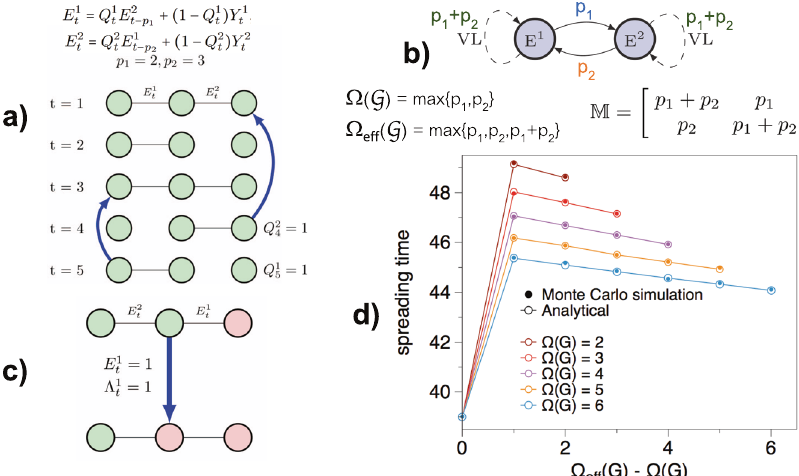
Fig. 2 Virtual loops and their effects on spreading processes in temporal networks. a A sketch of fi ve steps of the temporal evolution of a network with three nodes and two links evolving according to the displayed equation (for details see SI section IIIA). If Q ‘ t ¼ 0 then link ℓ at time t is generated randomly. Conversely, if Q ‘ t ¼ 1 link ℓ copies a state from the past, namely link 1 copies the value of link 2 at time t − 2, while link 2 copies the value of link 1 at time t − 3. b Bayesian graph of the causal dependencies between the two links. Link 1 copies from the past of link 2 ( p 1 ), whereas link 2 copies from the past of link 1 ( p 2 ), thereby inducing fi rst-order virtual loops in the memory of links 1 and 2, which virtually copy from their own past, p 1 + p 2 steps back. The co-memory matrix M whose entries are the co-memory order of each pair of links is also shown. The scalar memory of the process is Ω ð G Þ ¼ max f p 1 ; p 2 g (for a rigorous proof, see SI section IIIA), whereas the effective memory Ω eff ð G Þ , obtained as the largest entry of the co-memory matrix, is p 1 + p 2 , which differs from Ω ð G Þ due to the existence of the virtual loops. c A SI (Susceptible-Infectious) epidemic spreading is de fi ned over the temporal network. Each node can either be in the infected (red) or susceptible (green) state. If at time t there is a link E ‘ t ¼ 1 between an infected node and a susceptible one, then the infection will be passed with some probability (if random variable Λ t = 1) and the susceptible node will become infected (see SI section IIIE for details). d Analytical and numerical results for the average time taken for every susceptible to become infected, as a function of the difference between the scalar memory Ω ð G Þ and the effective memory Ω eff ð G Þ (this latter being extracted from M ). For each curve, the value of Ω ð G Þ is fi xed to a constant value p 1 , while the value of Ω eff ð G Þ ¼ p 1 þ p 2 is varied by changing p ≤ p fi nd that the spreading times depend on the value of the effective memory Ω G Þ , which is then a better descriptor of the effects of memory than 2 1 . We eff ð Ω ð G Þ , this latter quantity being unable to detect any of these effects. Numerical results are obtained as averages over 10 7 realisations of the network, and are in perfect agreement with the analytical prediction (see SI section IIIF for the full